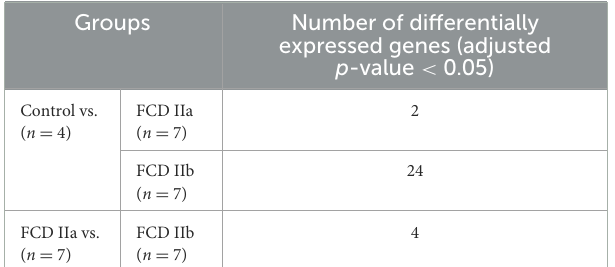
TABLE 4 Number of differentially expressed genes of the white matter comparing the autopsy (control), focal cortical dysplasia (FCD) ILAE